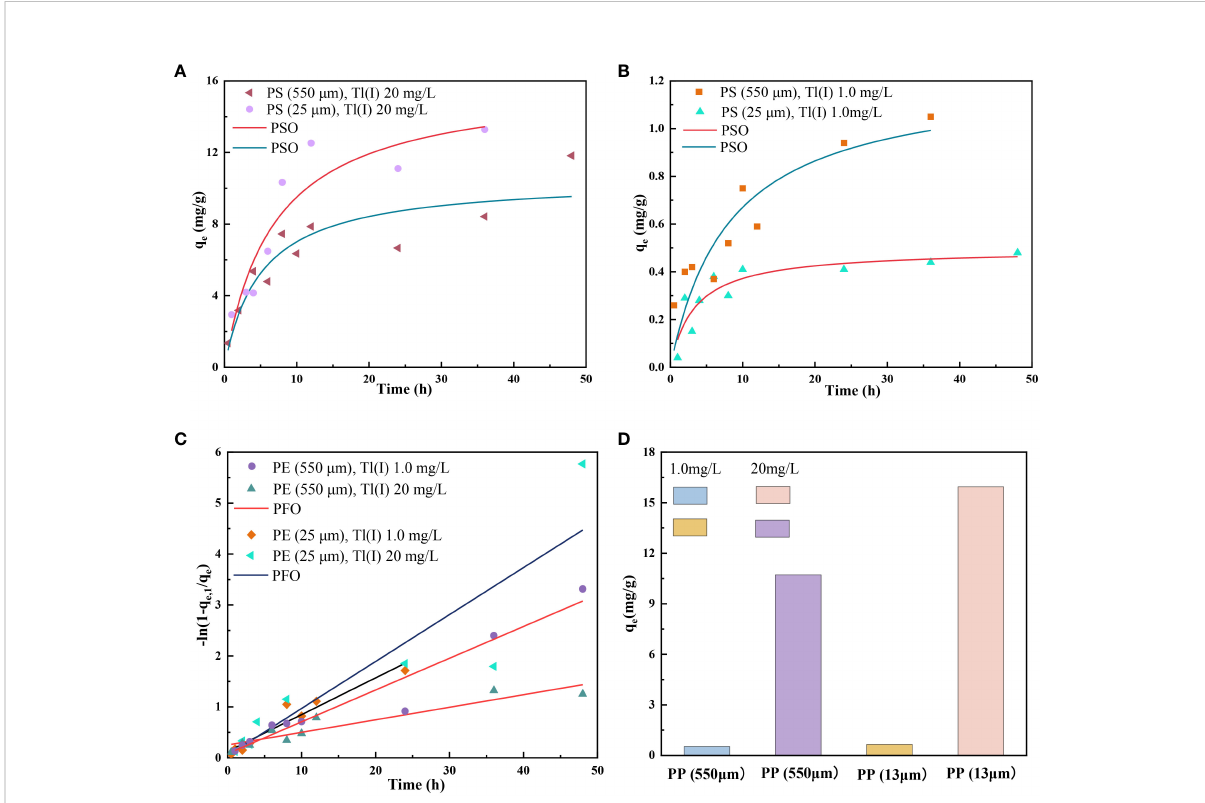
FIGURE 1 Adsorption kinetics. (A) PS + low initial Tl(I); (B) PS + high initial Tl(I); (C) PE + low and high initial Tl(I); (D) PP + low and high initial Tl(I). PFO means Pseudo- fi rst-order kinetic model; PSO means Pseudo-second-order kinetic model. Adsorption results of Tl by PP did not fi t into any of the kinetic